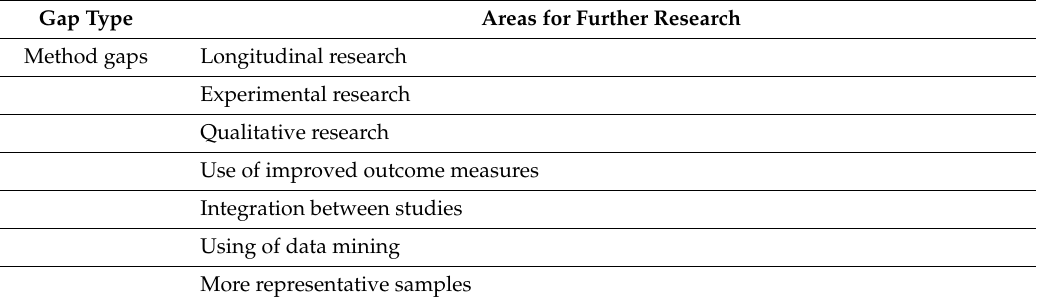
Table 2. Typology of